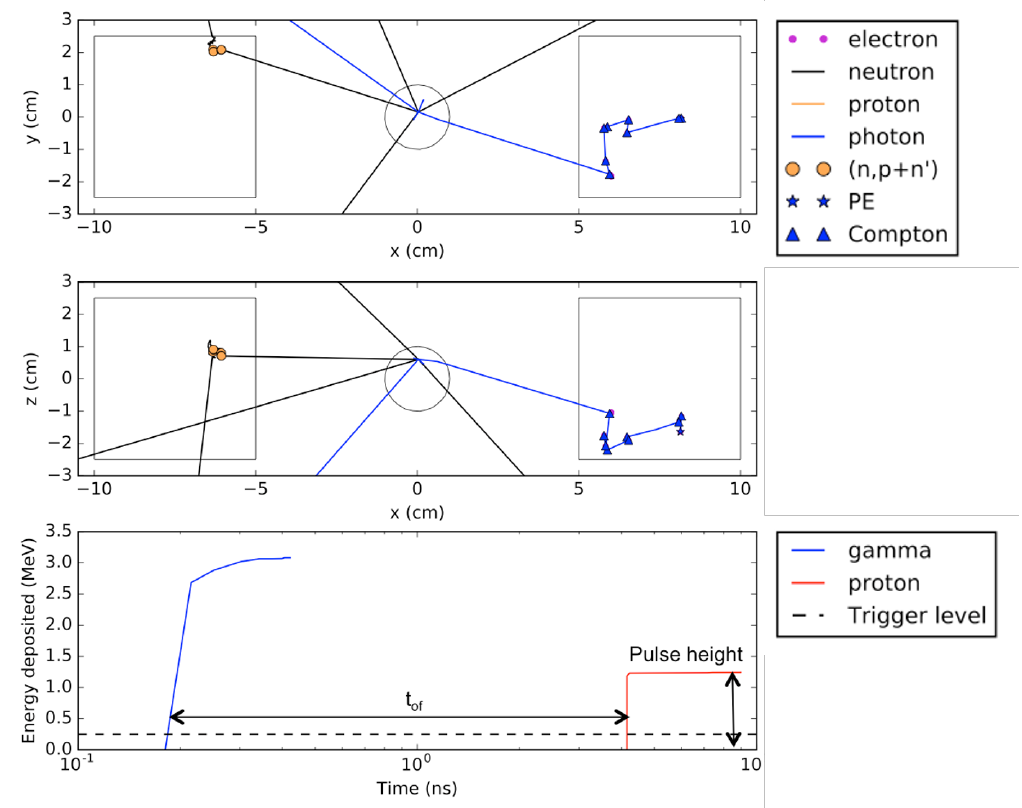
Figure 3: Particle tracks plotted for an event history of interest, with the associated energy deposition in both detector